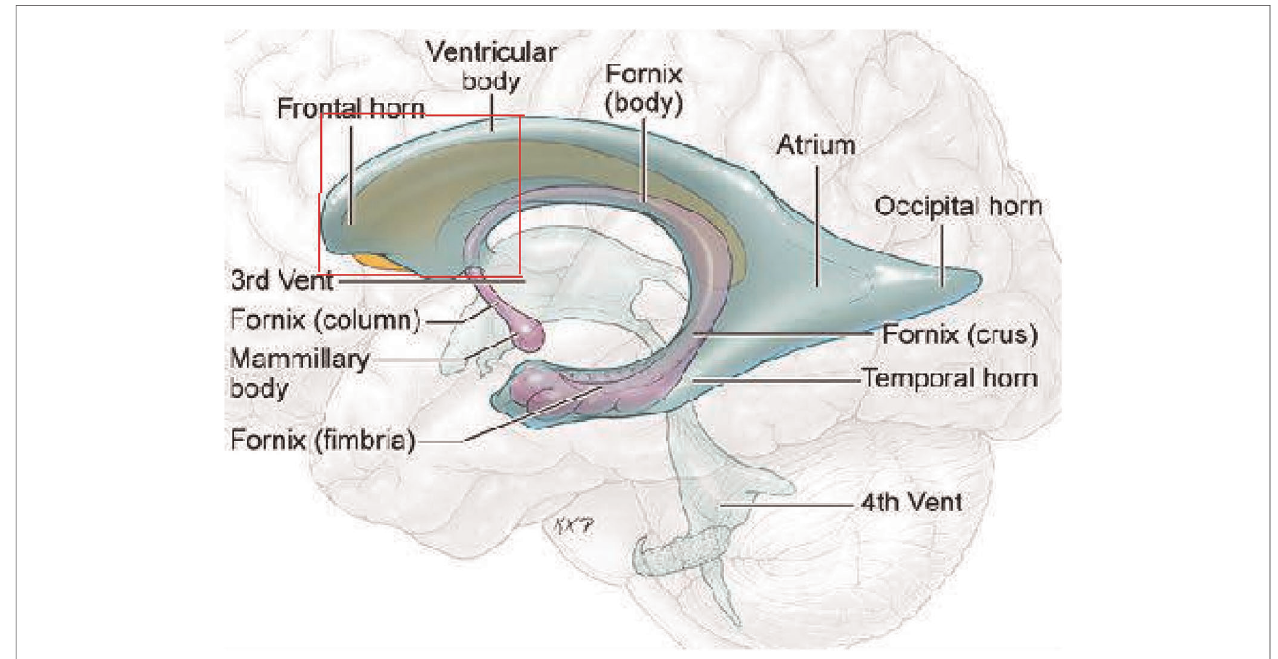
FIGURE 1 | Red box showing the anterior part of the lateral